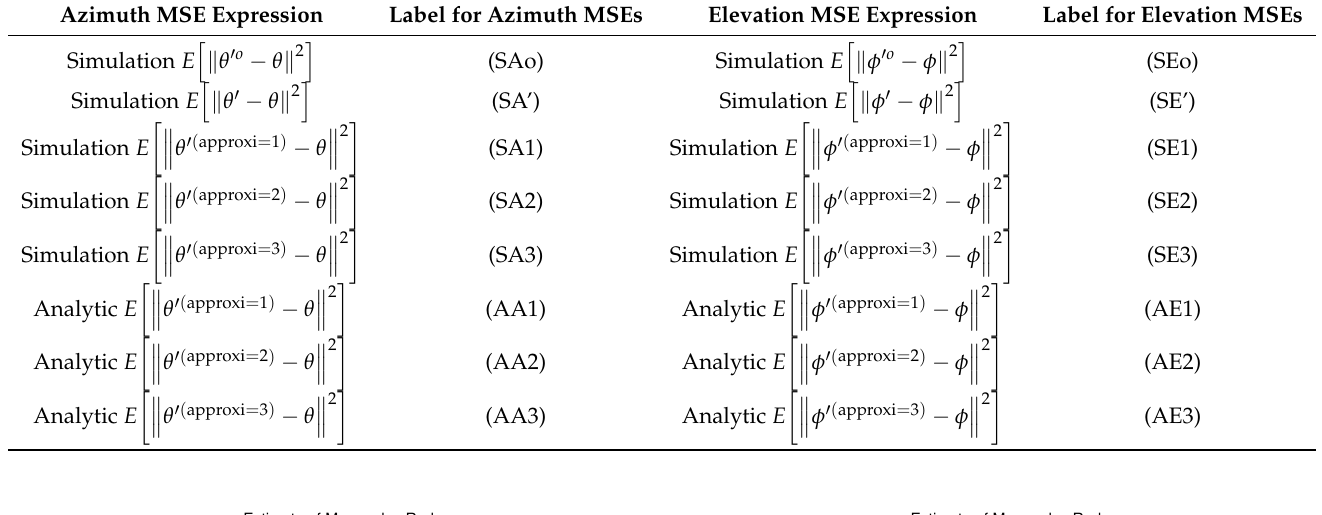
Table 1. Labels for MSE expressions.